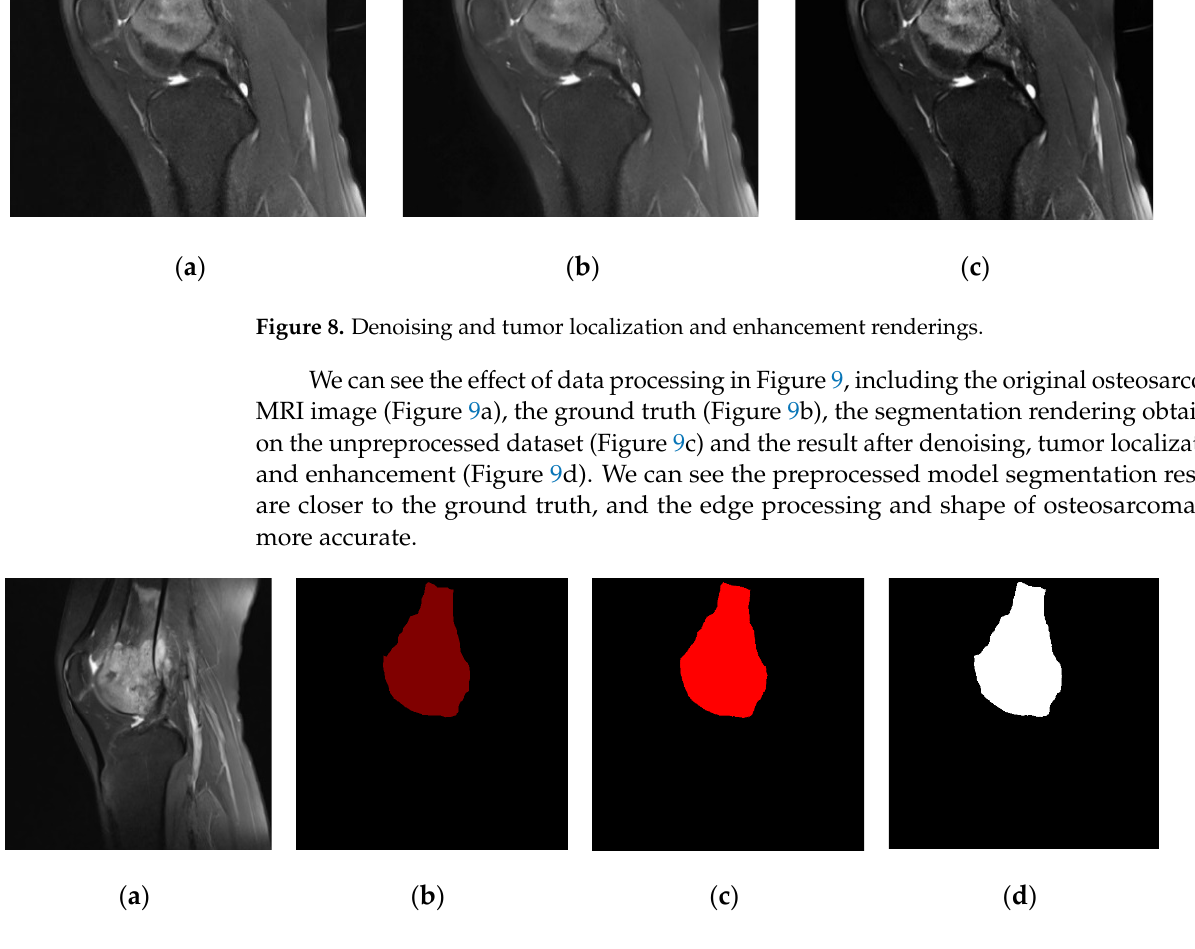
Figure 9. Comparison of segmentation effects before and after preprocessing.